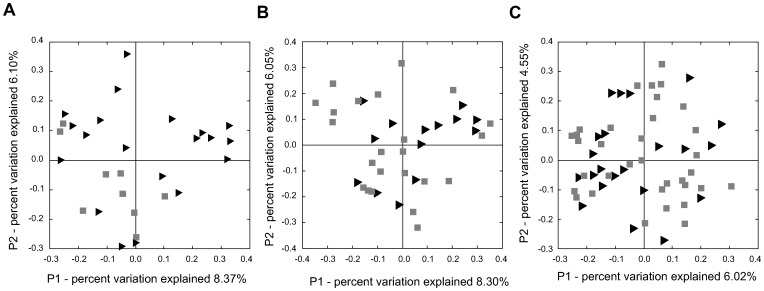
Unifrac diversity measures.Principal component analysis (PCA) of overall diversity based on UniFrac (unweighted) metric A) 2 weeks before; B) 1 week before; and C) week of diagnosis of NEC. Squares represent controls and triangles represent cases. P1 is component 1 and P2 component 2.